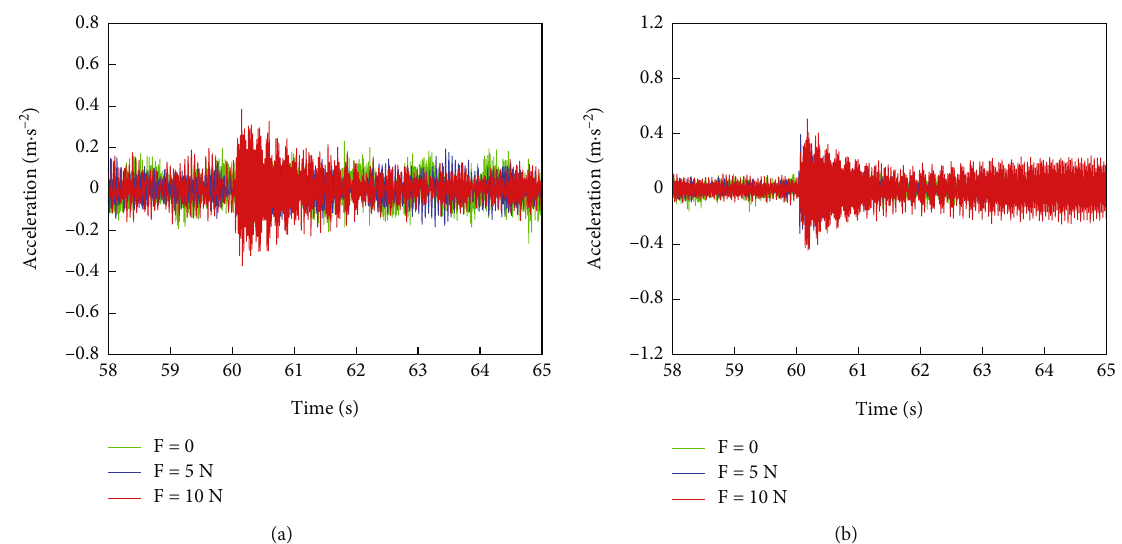
Figure 15: Acceleration response with LMS-IOBR at secondary path mutation (58-65s). (a) 1# point. (b) 2#